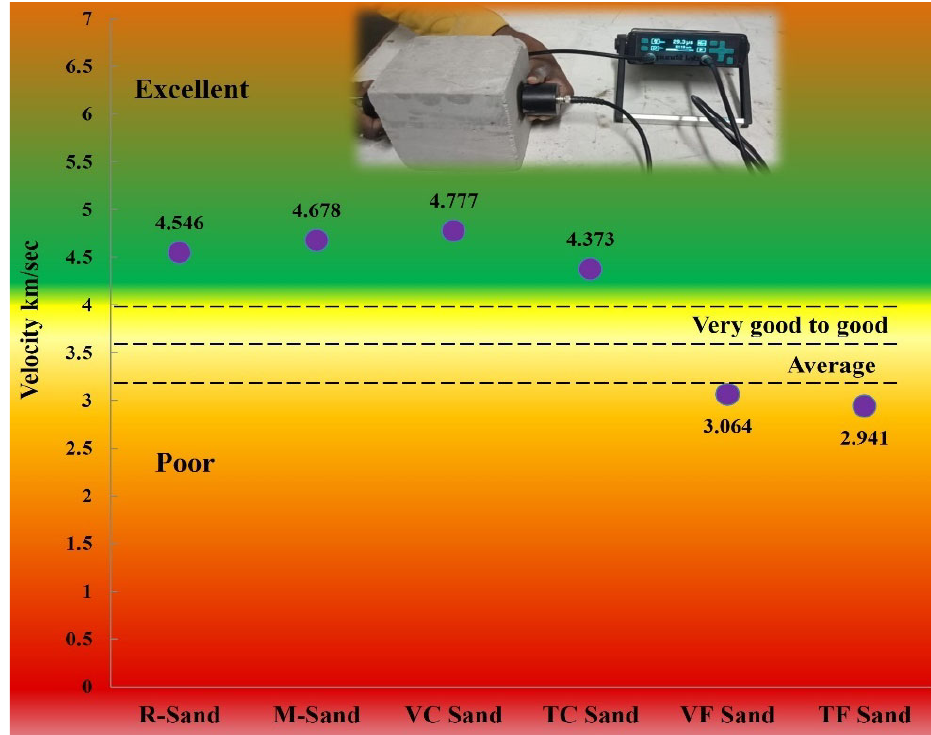
Figure 17. Ultrasonic pulse velocity results.